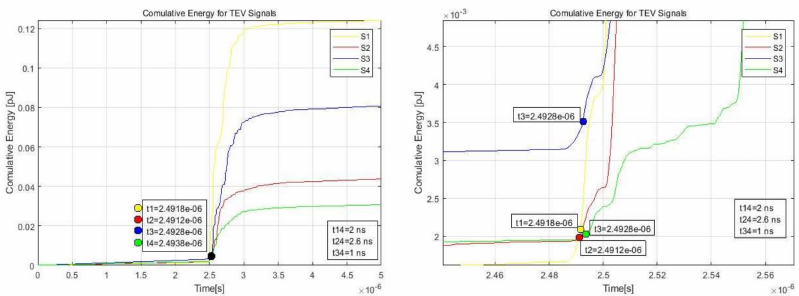
Figure 7. The cumulative energy curves with Zoom for (4 TEV) sensors for PD source at location